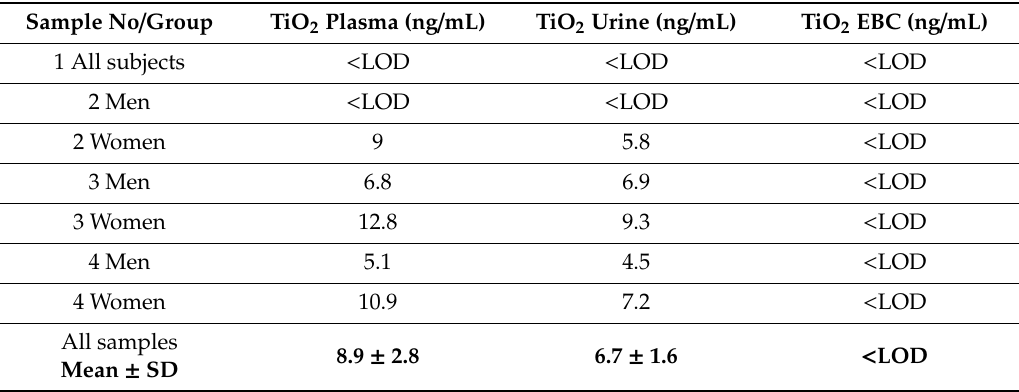
Table 2. TiO 2 concentration measured in the plasma, spot urine, and exhaled breath condensate (EBC) in study A (sunscreen only). Limit of detection (LOD) 1.2 ng / mL.